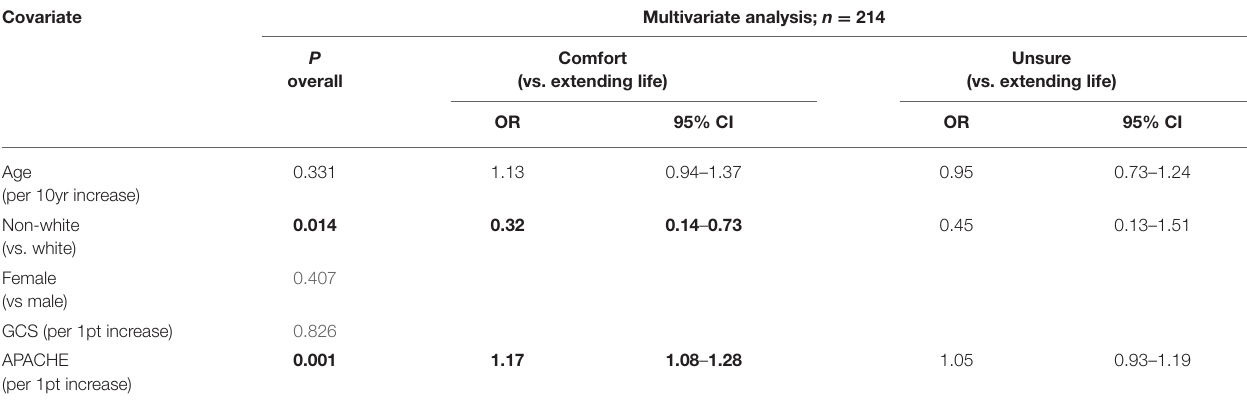
TABLE 2 | Determinants of presumed prioritized healthcare goals at enrollment ( n = 214). Covariate Multivariate analysis; n = 214